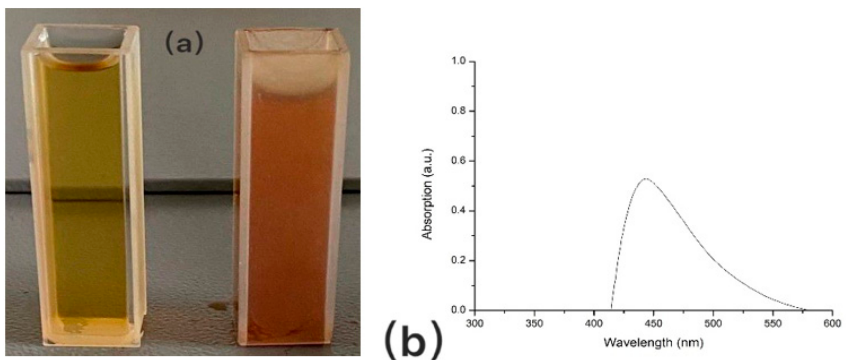
Figure 1. Biosynthesis of silver nanoparticles mediated by C. Canadensis . ( a ) Image of leaf extract without and with AgNO 3 , ( b ) UV ‐ vis absorption spectrum of silver nanoparticles.